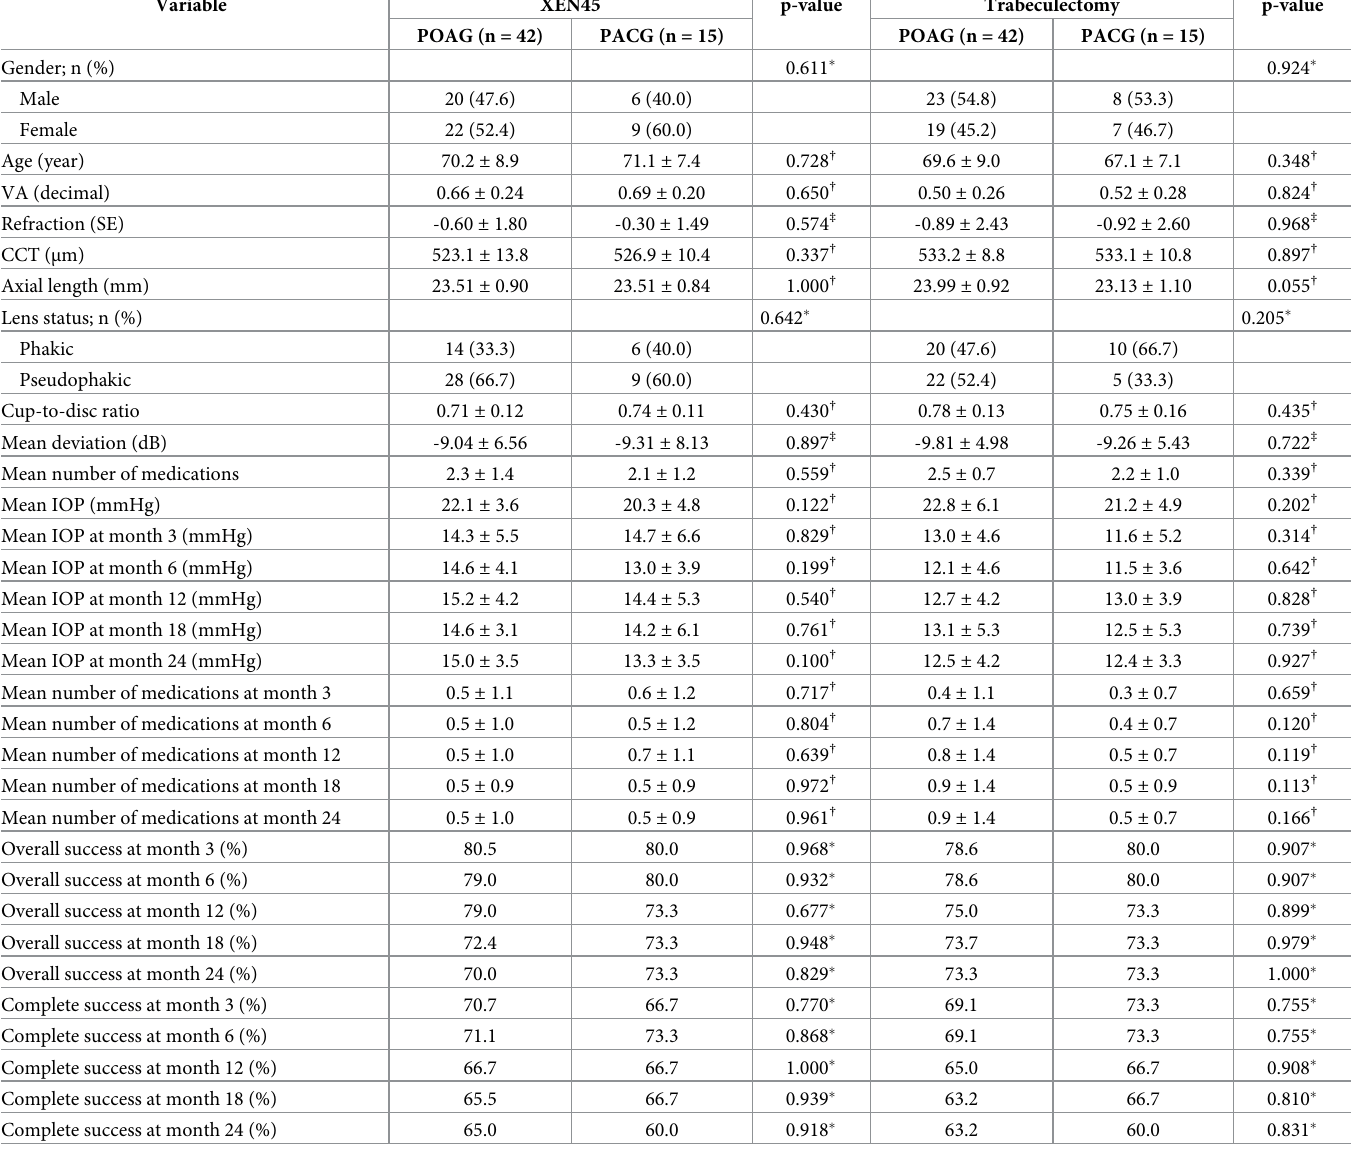
Table 2. Characteristics of XEN45 and trabeculectomy in POAG and